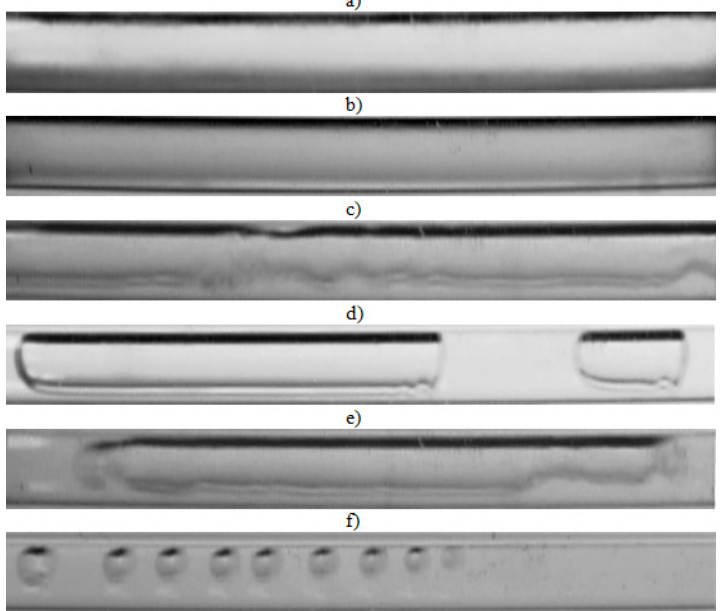
Figure 7. Experimental results of visualization research on HFE7100 refrigerant condensation in a minichannel with an internal diameter d h = 2.0 mm: ( a ) mist flow G = 265 kg/m 2 s, x = 0.82, ϕ = 0.97, ts = 59 °C; ( b ) annular flow G = 1291 kg/m 2 s, x = 0.5, ϕ = 0.87, t s = 58 °C; ( c ) annular flow G = 469 kg/m 2 s, x = 0.14, ϕ = 0.52, t s = 59 °C; ( d ) plug flow G = 309 kg/m 2 s, x = 0.1, ϕ = 0.43, t s = 59 °C; ( e ) slug flow G = 1415 kg/m 2 s, x = 0.18, ϕ = 0.59, t s = 59 °C; ( f ) bubbly flow G = 424 kg/m 2 s, x = 0.01, ϕ = 0.09, t s = 59 °C.